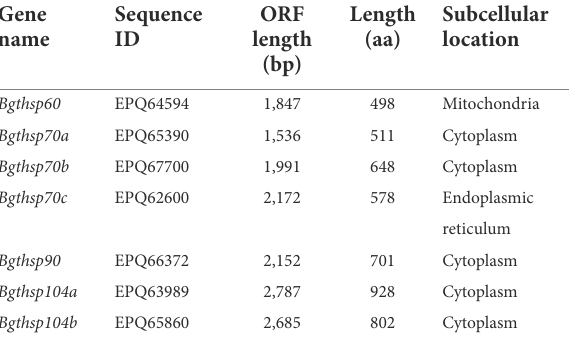
TABLE 4 Features of heat shock protein gens identified in B. graminis f. sp. tritici